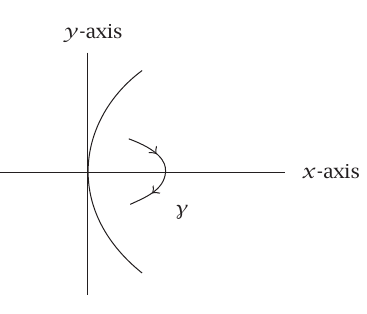
Figure 5.2 . The local behavior of γ